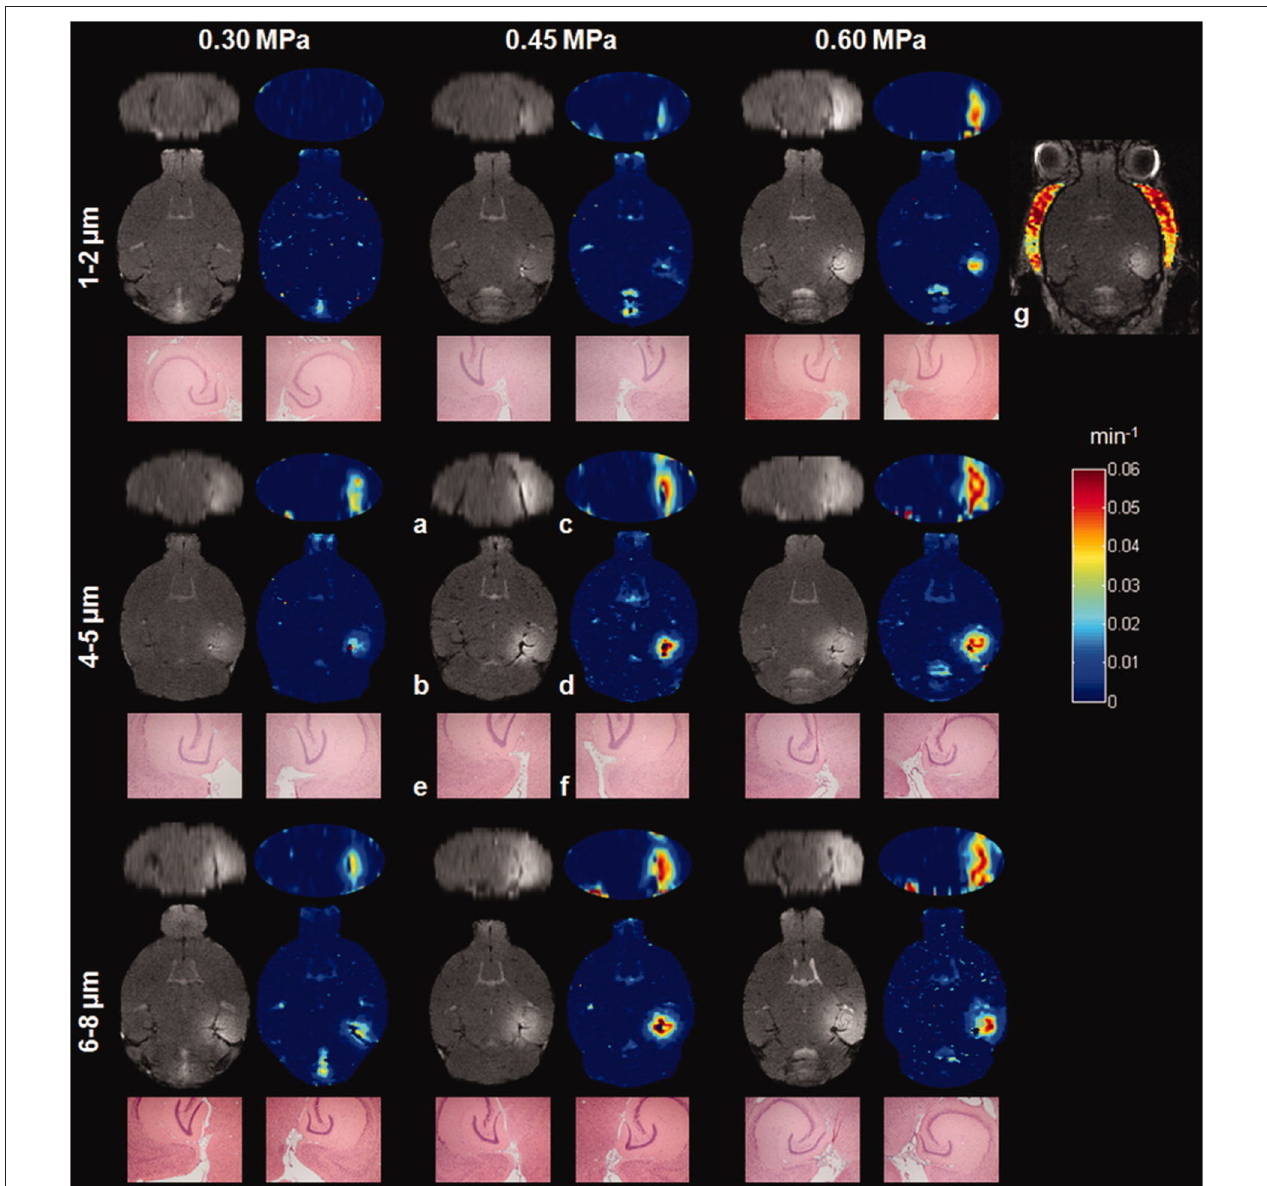
FIGURE 4 | Contrast-enhanced T1-weighed MR images and permeability maps obtained by [61] with different APs (0.30–0.60 MPa) and MBs (sizes ranging between 1 and 8 µ m). As can be noticed from the figure, MR images can reveal a larger disruption of the BBB at the increasing of the APs and the size of MBs used. Reproduced with permission from